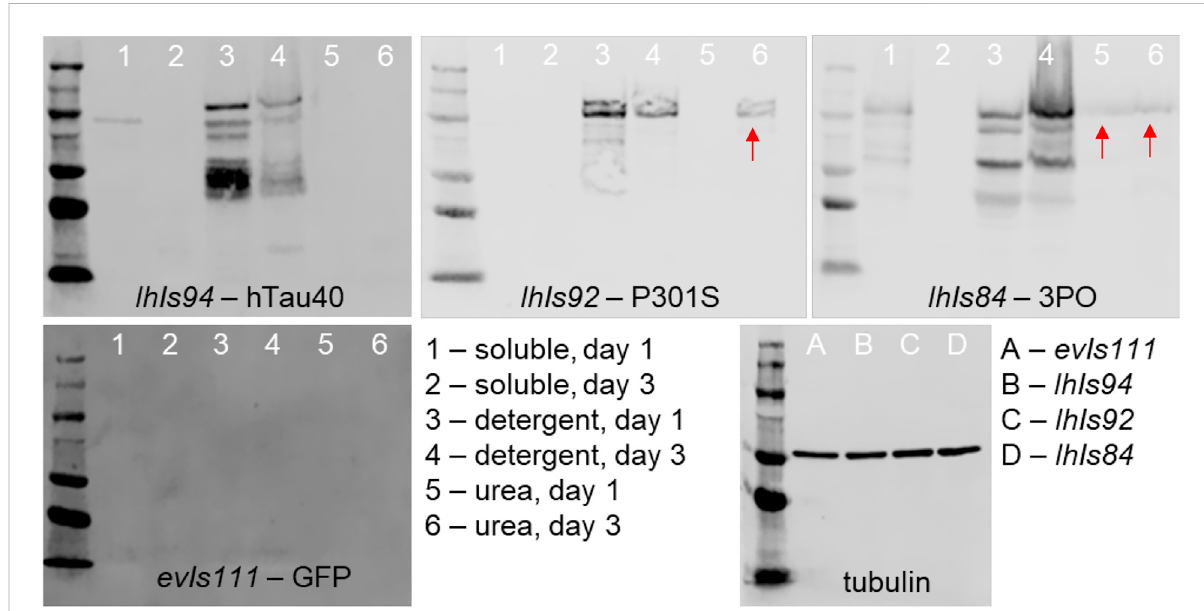
FIGURE 4 Serial biochemical extraction of aggregated tau. Protein was extracted from transgenic animals of the indicated genotype and day, then subjected to a series of extraction steps to collect the soluble (lanes 1 and 2), detergent soluble (lanes 3 and 4) and urea soluble (lanes 5 and 6) fractions. Fractions were separated by SDS-PAGE and detected using tau antibodies and chemiluminescence. The presence of tau in the urea fractions (red arrows) is indicative of aggregates that have formed. We found that tau is present in this fraction by day 1 of adulthood in 3PO expressing lines and by day 3 in P301S expressing lines. To the bottom right is a blot of extracts from day 1 animals of the indicated genotype of a control protein, tubulin, to demonstrate equal loading.